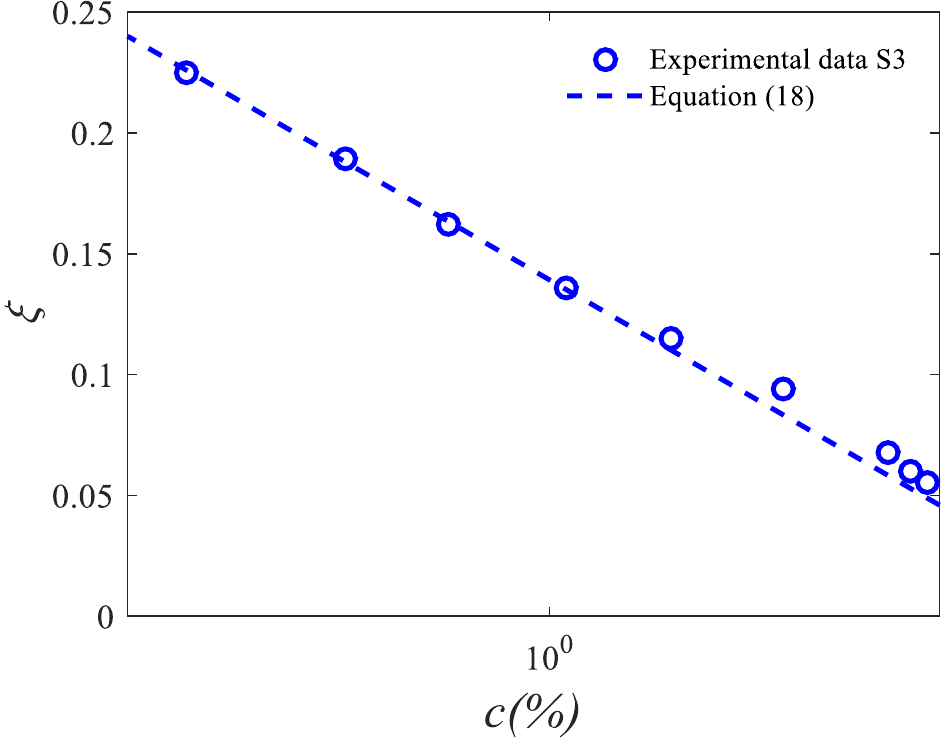
Figure 2. Concentration profile in semi-log plot, for coarse sediments.